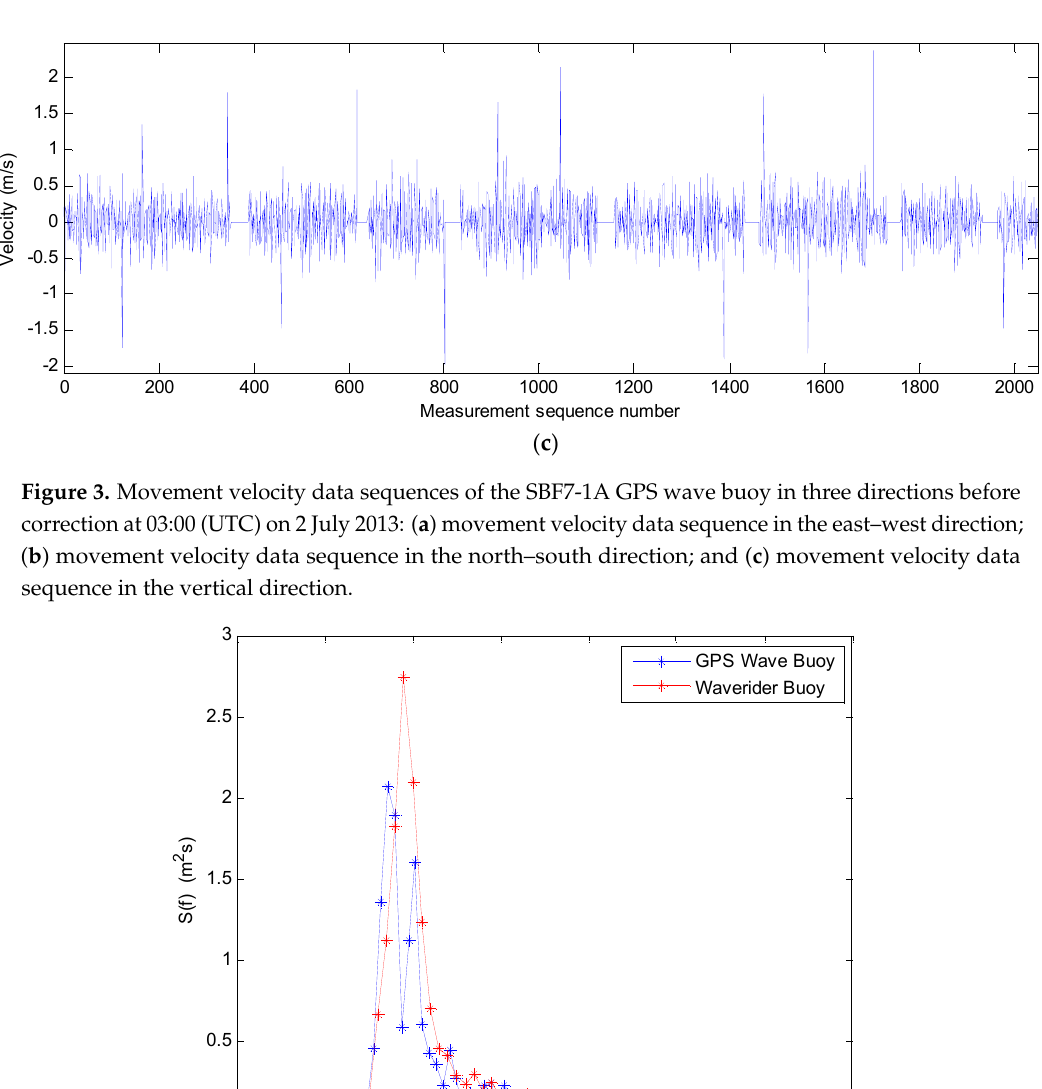
Figure 3. Movement velocity data sequences of the SBF7-1A GPS wave buoy in three directions before correction at 03:00 (UTC) on 2 July 2013: ( a ) movement velocity data sequence in the east–west direction; ( b ) movement velocity data sequence in the north–south direction; and ( c ) movement velocity data sequence in the vertical direction.